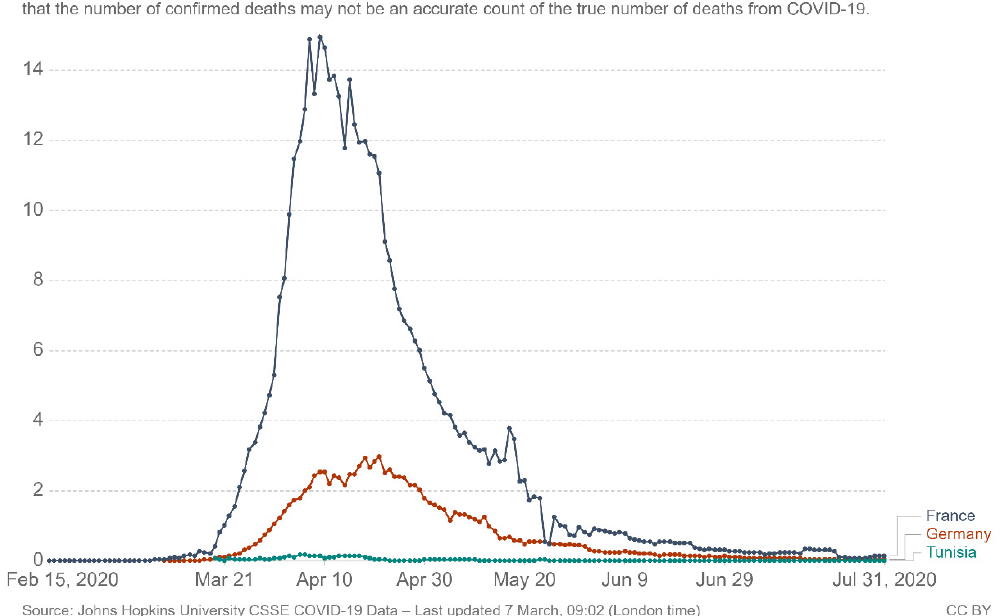
Figure 2. Shown is the rolling 7-day average of deaths caused by coronavirus in France, Germany, and Tunisia from 1 February 2020 to 31 July 2020. Source: Max Roser HR, Esteban Ortiz-Ospina, Joe Hasell. Posted online on OurWorldInData.org, 30 January 2021.